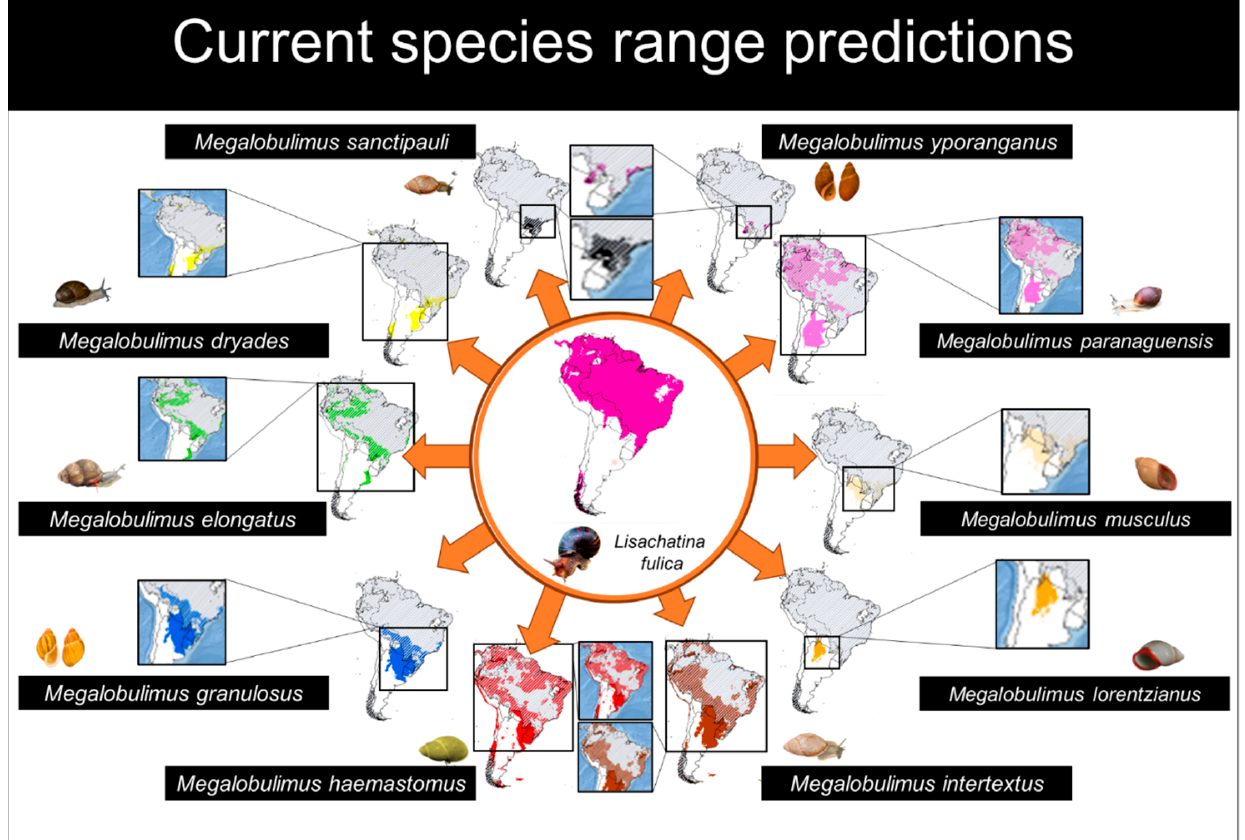
Figure 2. Predicted distribution maps for the current scenario of the ten species of Megalobulimus and Lissachatina fulica . The native species are represented by the following colors: M. sanctipauli (black), M. dryades (yellow), M. elongatus (green), M. granulosus (blue), M. haemastomus (red), M. intertextus (brown), M. lorentzianus (orange), M. musculus (beige), M. paranaguensis (pink), and M. yporanganus (purple). The lines on the maps for each species correspond to the distribution of L. fulica .